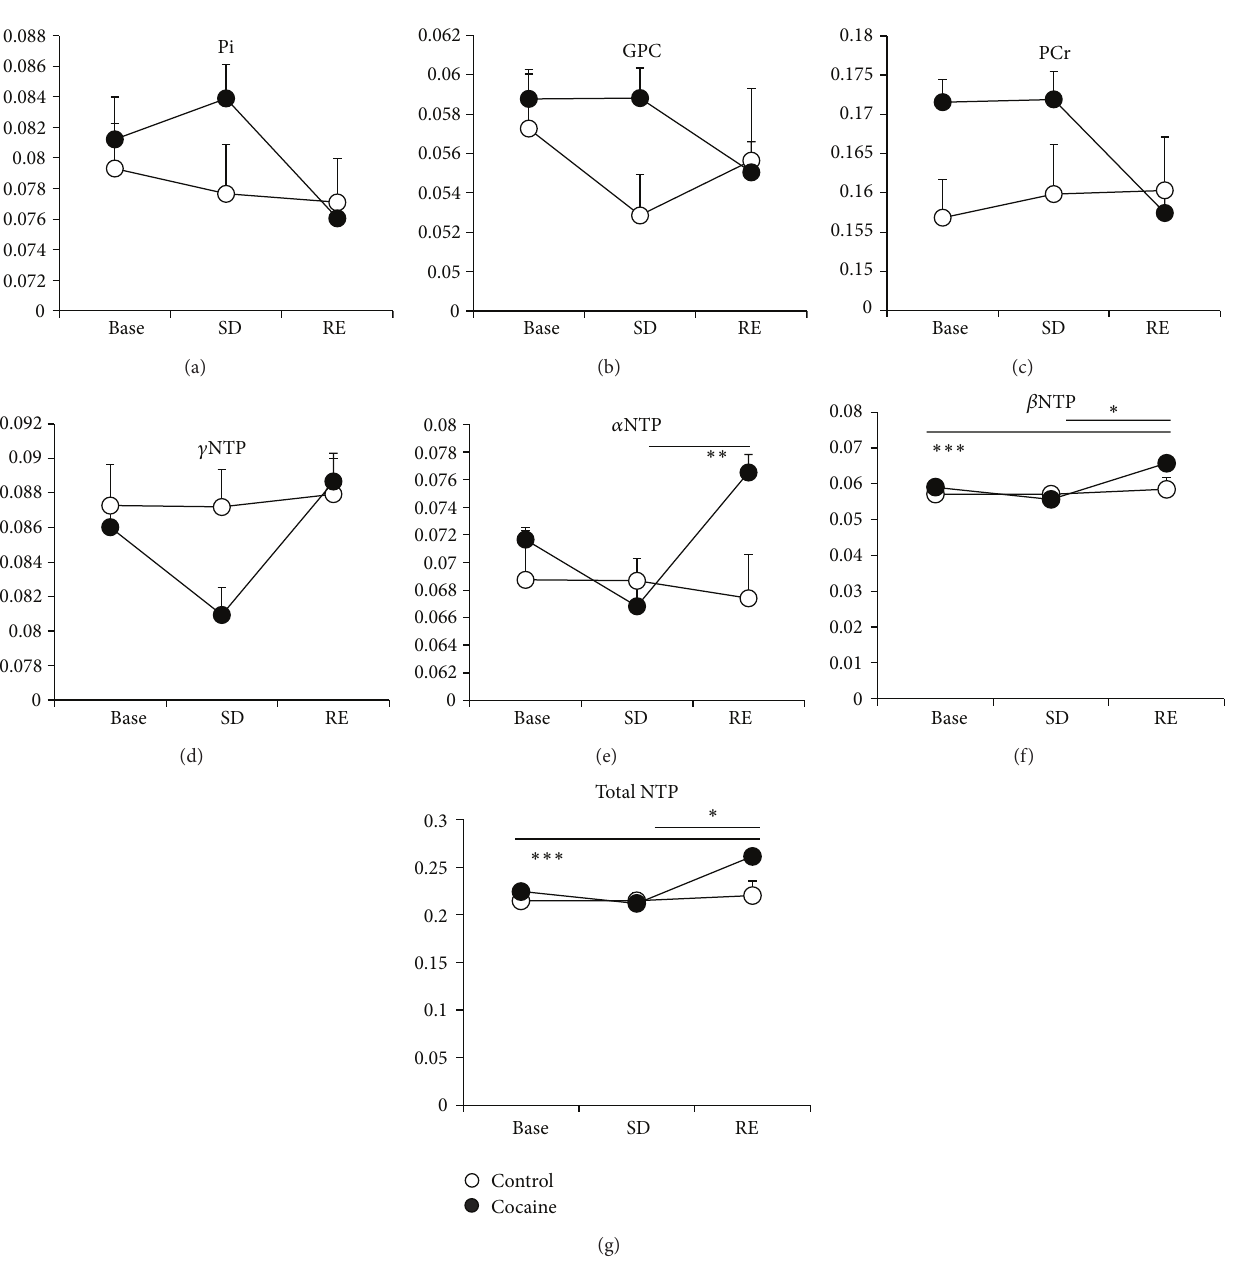
Table 2. There were no baseline differences, no effect of age, and no sleep night ∗ group interaction for any polysomno- graphic variable. In both groups on recovery sleep night, SOL was shorter ( 𝐹 [1,39] = 4.75 ; 𝑃 = 0.036 ), wakefulness after